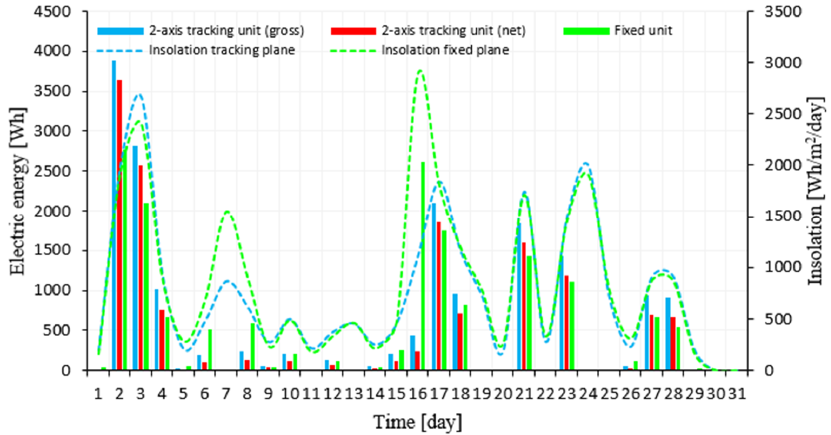
Figure 14. Variability of the electricity production and the determined insolation for photovoltaic modules in the fixed and dual-axis tracking configurations in December 2016.